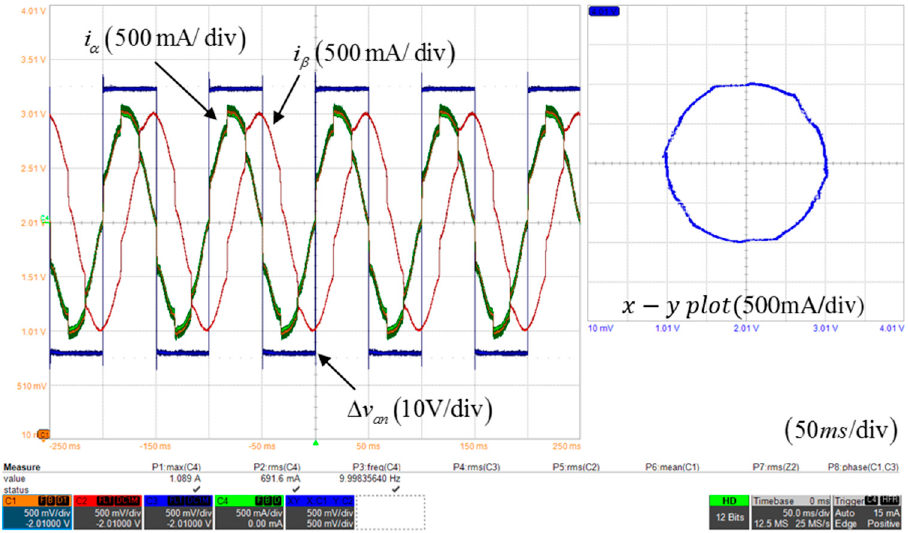
Figure 28. Stationary reference frame α β− axis and on the x-y plot current waveforms with Figure 24.